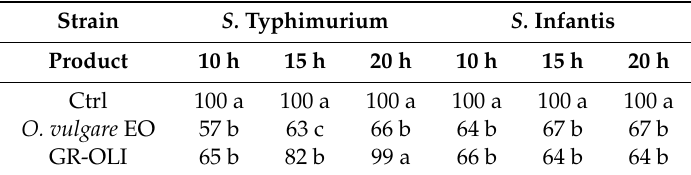
Table 3. Relative growth of S. Typhimurium and S. Infantis at 10, 15, and 20 h after treatment with O. vulgare EO and GR-OLI vs. untreated control ( = 100).